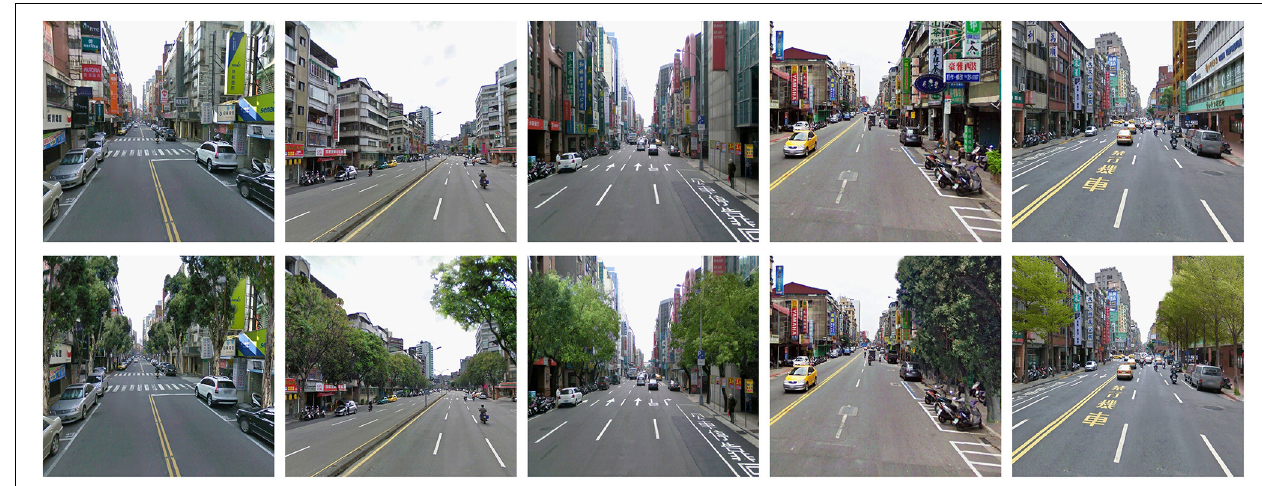
FIGURE 1 | Streetscape images. (Upper row, streetscape with no greenery; Lower row, streetscape with simulated greenery).